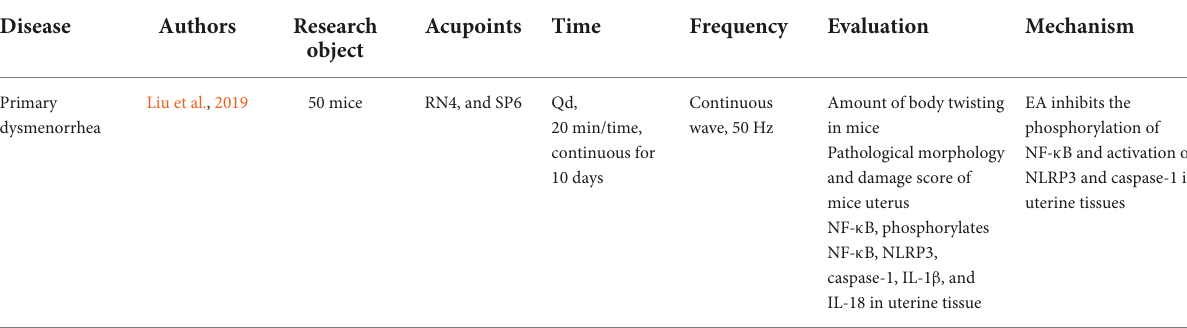
TABLE 4 Mechanism of electroacupuncture targeting NLRP3 inflammasome in the treatment of primary